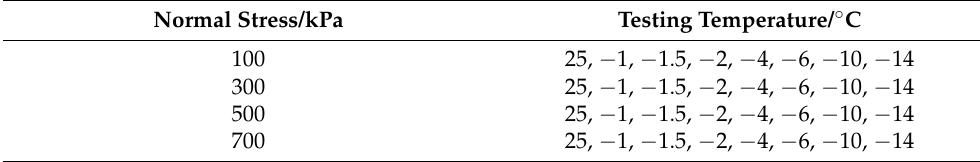
Table 2. Testing parameters.